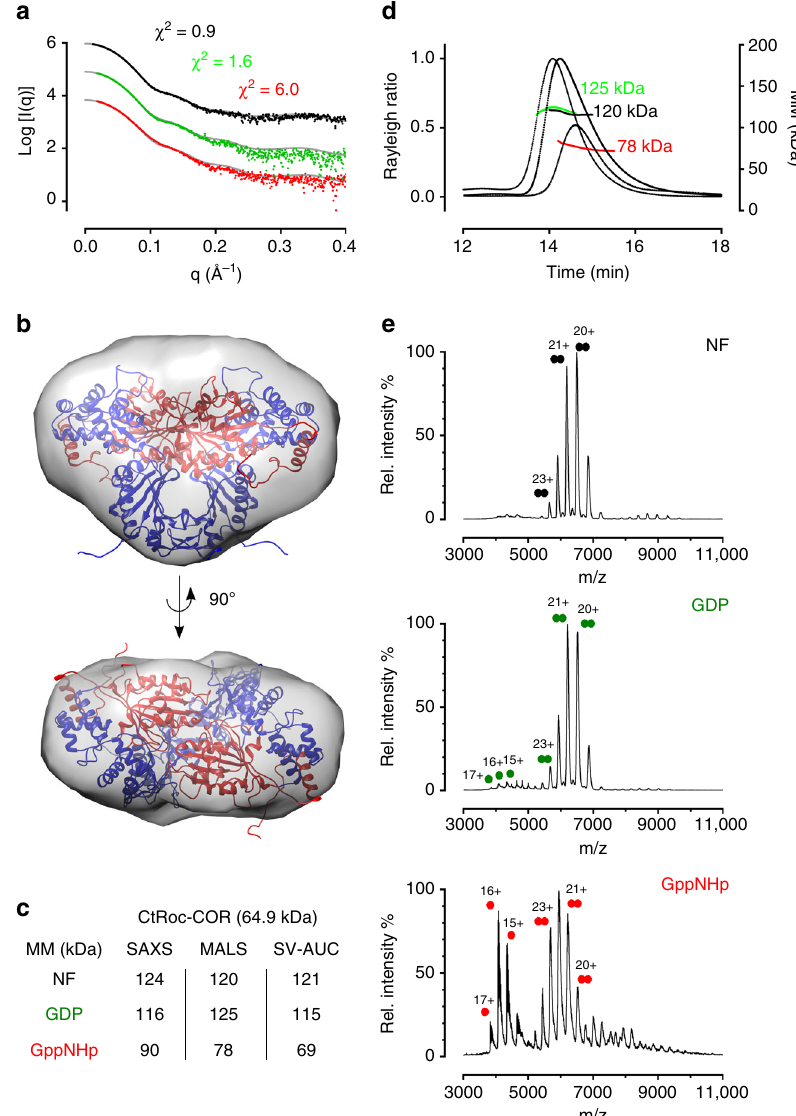
Fig. 1 The Chlorobium tepidum Roc-COR domain monomerizes upon binding of a non-hydrolysable GTP analogue (GppNHp). a Pairwise-comparison using CRYSOL of the theoretical scattering curve derived from the crystallographic dimer model of CtRoc-COR (PDB 3DPU, grey line ) with the experimental scattering curves of CtRoc-COR in the absence of nucleotides ( black dots ) or in the presence of GDP ( green dots ) or GppNHp ( red dots ). b Superposition of the crystallographic CtRoc- COR dimer model (Roc in red and COR in blue ) on the ab initio SAXS envelope, constructed starting from the scattering curve of CtRoc-COR in the absence of nucleotides. c Overview of the molecular masses obtained via SAXS (based on Porod volume/1.7), SEC-MALS and SV-AUC for CtRoc-COR in different nucleotide- bound states. The theoretical molecular mass of the monomer is given in between brackets. (NF = nucleotide-free) d SEC-MALS data for CtRoc-COR in the absence ( black ) or presence of nucleotides GDP ( green ) or GppNHp ( red ). e Native mass spectra of CtRoc-COR for the three different nucleotide states: nucleotide- free (NF), GDP-bound and GppNHp-bound. Peaks corresponding to dimeric and monomeric species are labeled with two circles and one circle , respectively NATURE COMMUNICATIONS | 8: